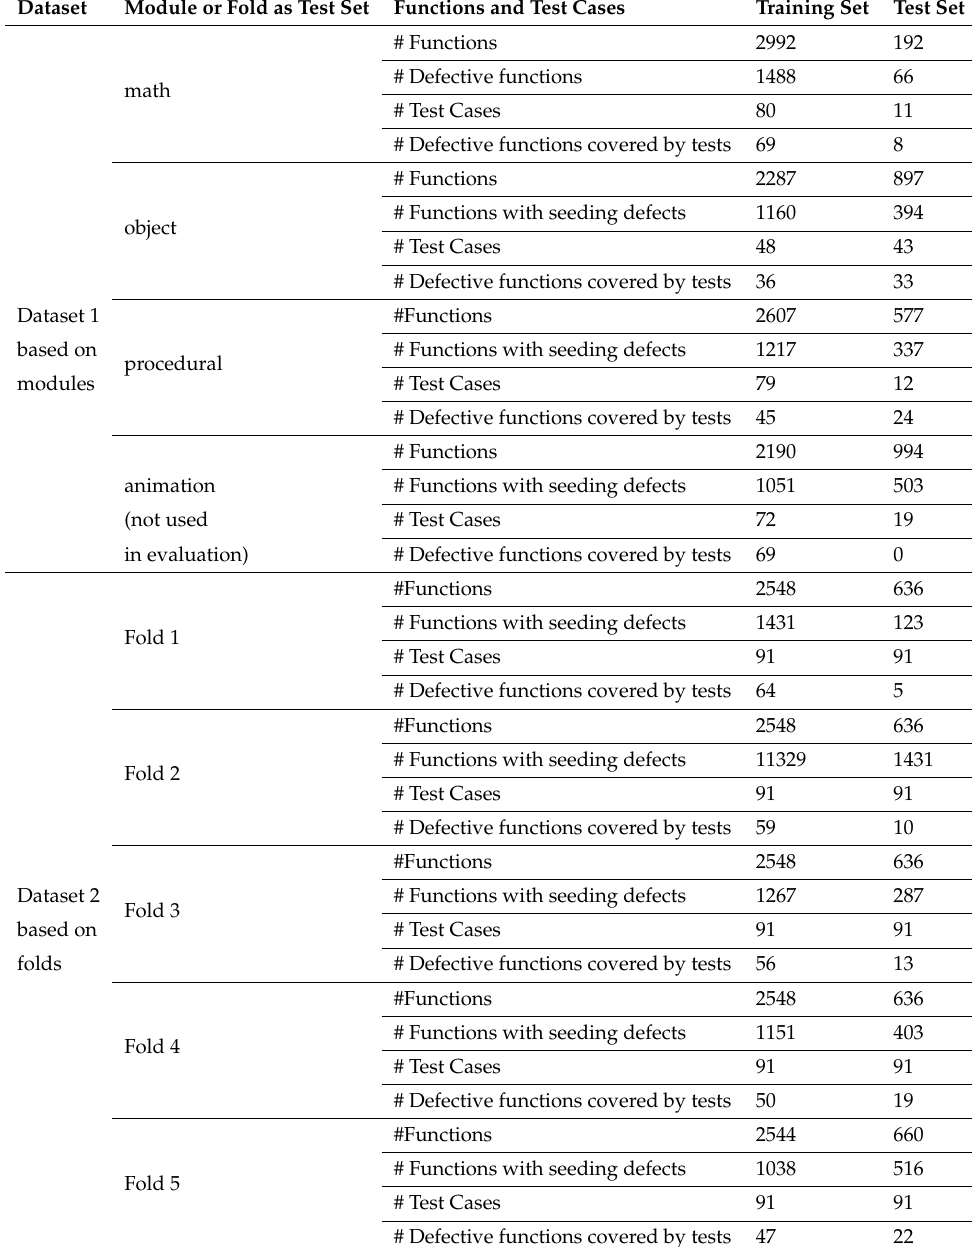
Table 3. Data information of training sets and test sets. We show the division of training sets and test sets of eight rounds of evaluation. # Defective functions covered by tests is the number of defective functions that are covered by test